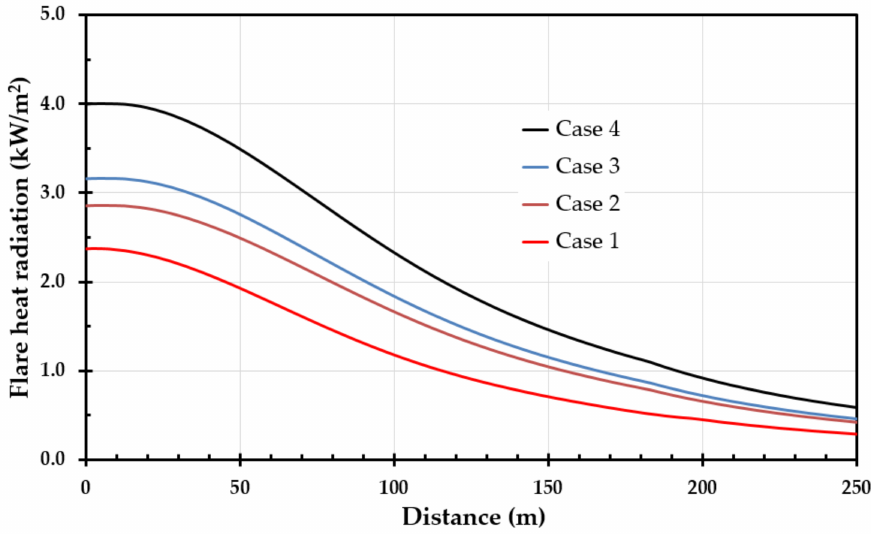
Figure 4. Net maximum flare heat radiation along the pavement for Cases 1, 2, 3, and 4, Table